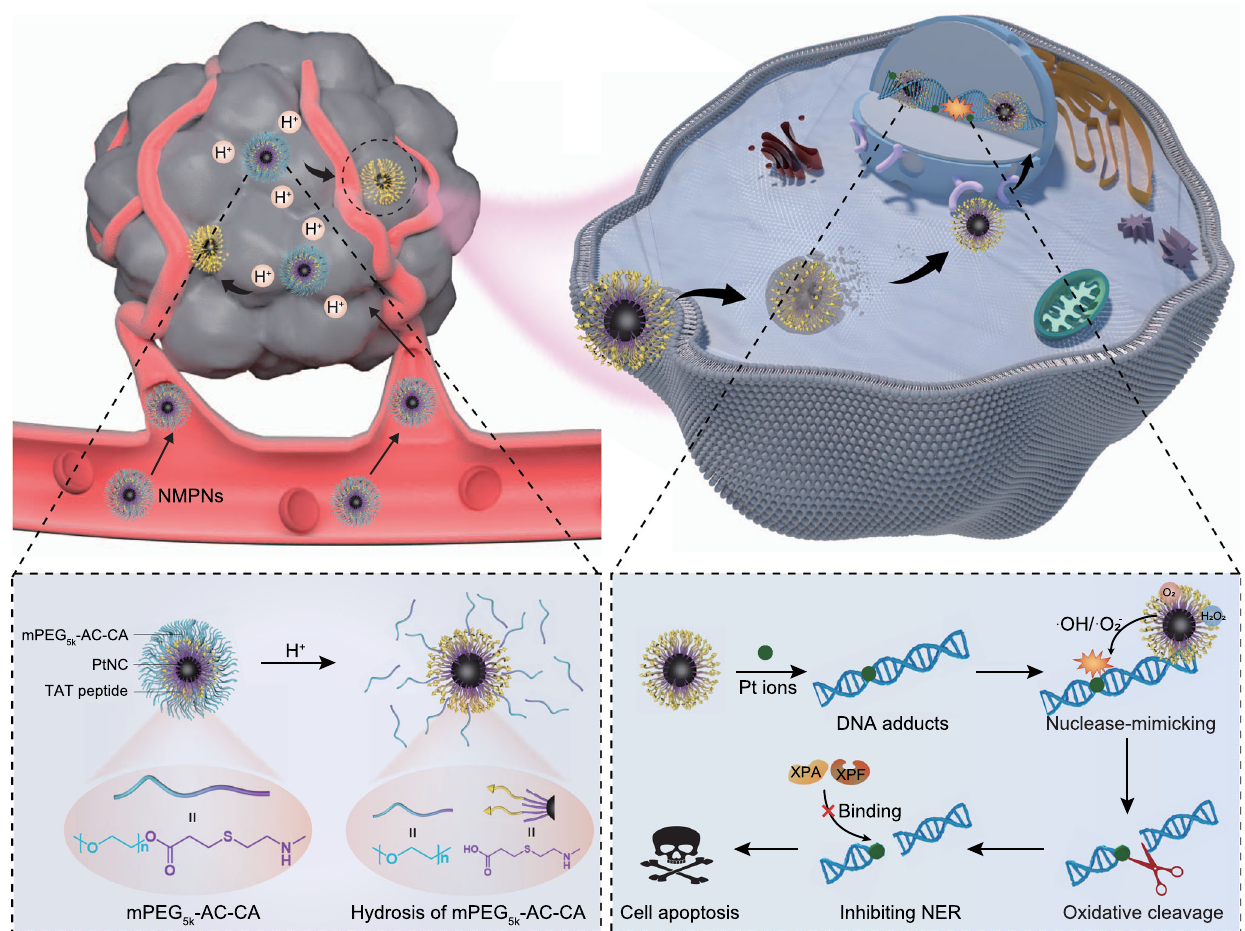
Fig. 1 | Schematic illustration ofNMPNs-mediatedconcurrent DNA platination and oxidative cleavage to overcome Pt resistance of cancer. The outermost mPEG 5K -AC-CA of NMPNs can be selectively dissociated in tumour acidic micro- environment due to the hydrolysis of the β -thiopropionate group, thus exposing TAT peptides to promote the endocytosis, endosomal escape, and nuclear trans- portation. NMPNs can ef fi ciently release Pt ions to induce Pt-DNA adducts in